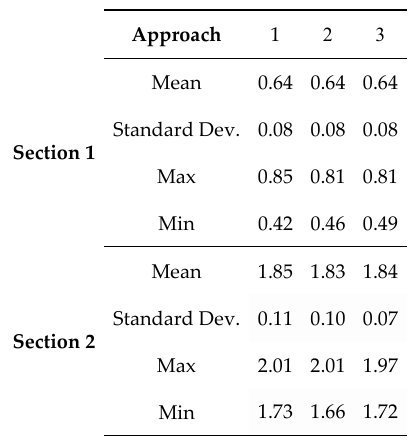
Table 1 Statistics of surface velocity measurements using three different approaches (ms -1 )